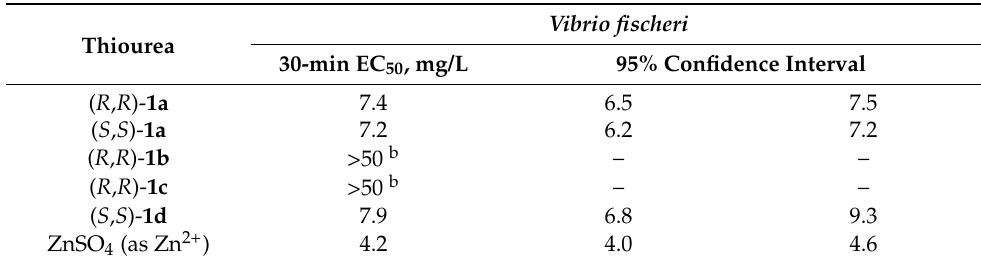
Table 1. Toxicity (30-min EC 50 , mg/L) of amino-functionalized thioureas 1a–d and the used positive control (ZnSO 4 ) to Vibrio fischeri a